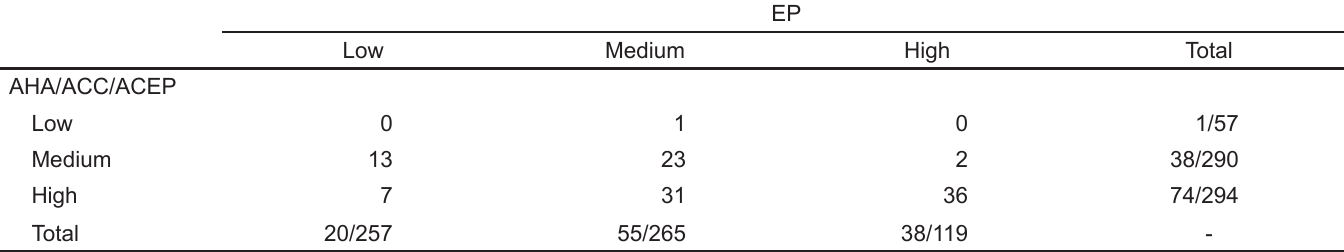
Table 3. Comparison of ACS positive diagnosis by EP and AHA/ACC/ACEP guidelines.